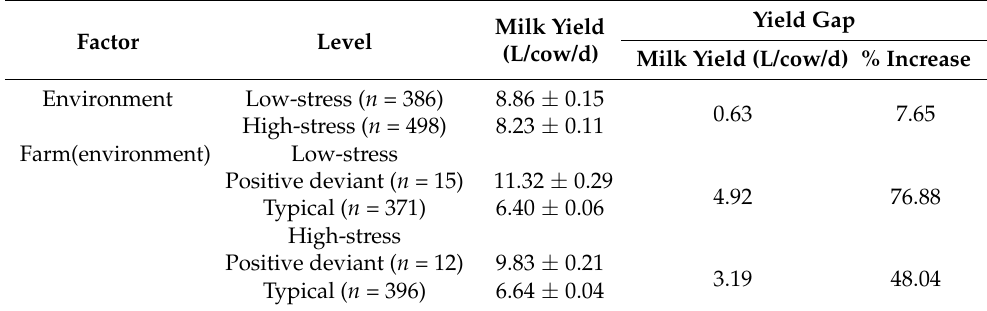
Table 4. Estimated means ( ± SE) for milk yield and yield gaps in typical farms relative to positive deviant farms and in the low-stress environment relative to the high-stress